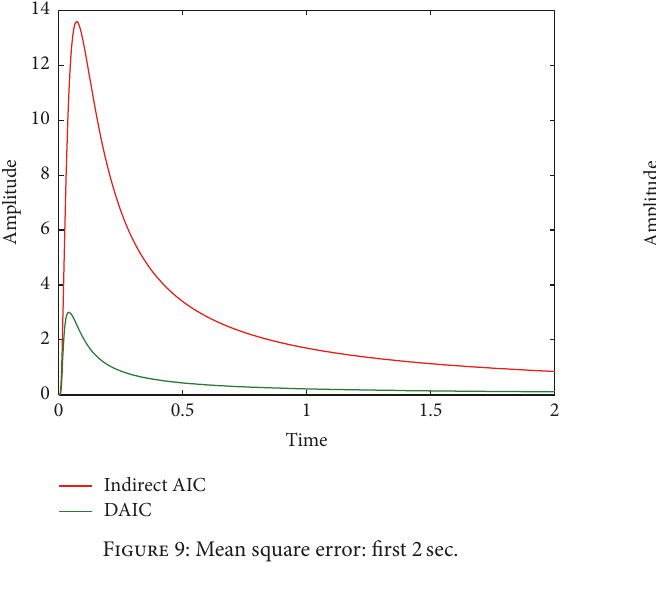
Figure 9: Mean square error: first 2sec.